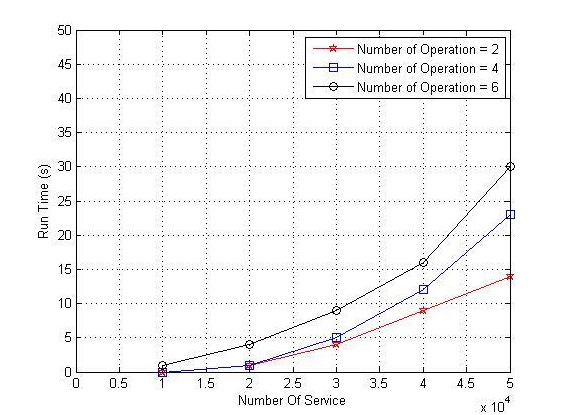
Figure 2. Runtime of executing a number of different Web services.